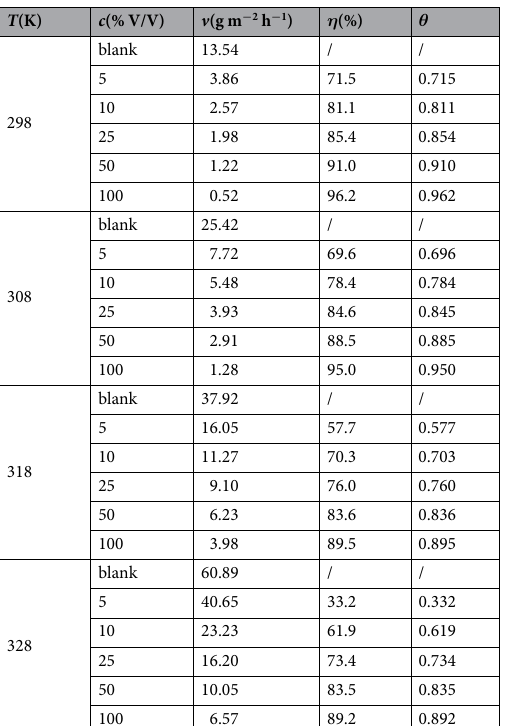
Table 3. Corrosion parameters obtained from weight loss measurements for mild steel in 0.5 M H 2 SO 4 solution without and with different V/V concentrations of LLE for 4 h at different temperatures.